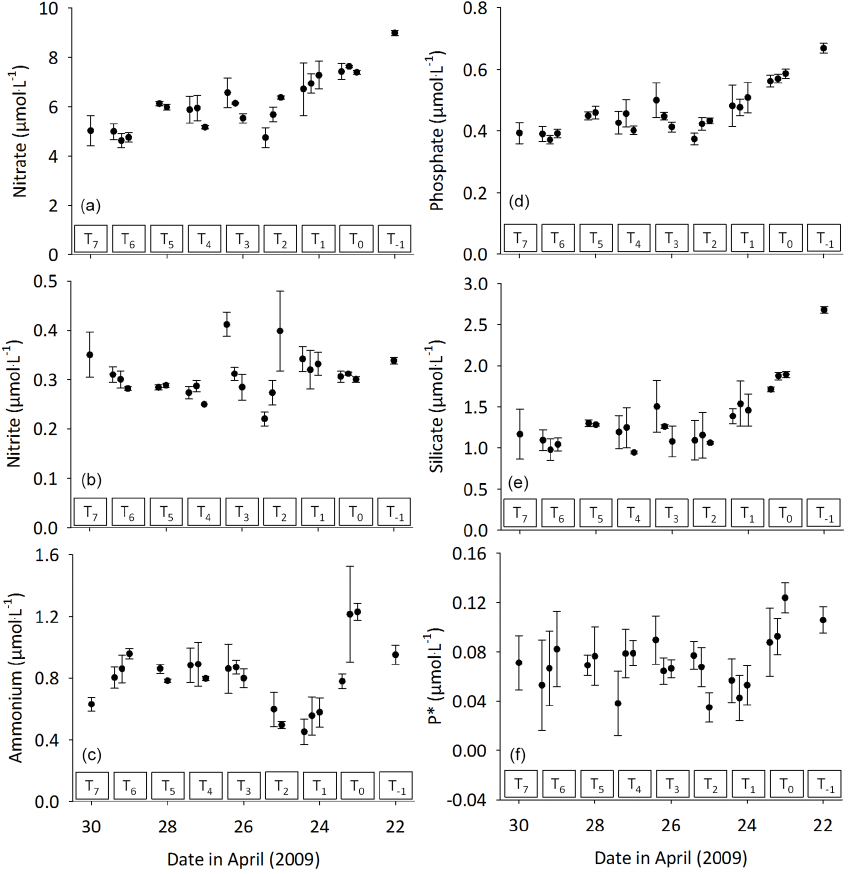
Figure 2. Average concentration of inorganic nutrients within the upper mixed layer: (a) nitrate, (b) nitrite, (c) ammonium, (d) phosphate, (e) silicate. The phosphate excess (P*) is presented in panel (f) . Error bars represent 1 standard deviation for triplicate concentration mea- surements. Note the reversal of dates to aid comparisons between